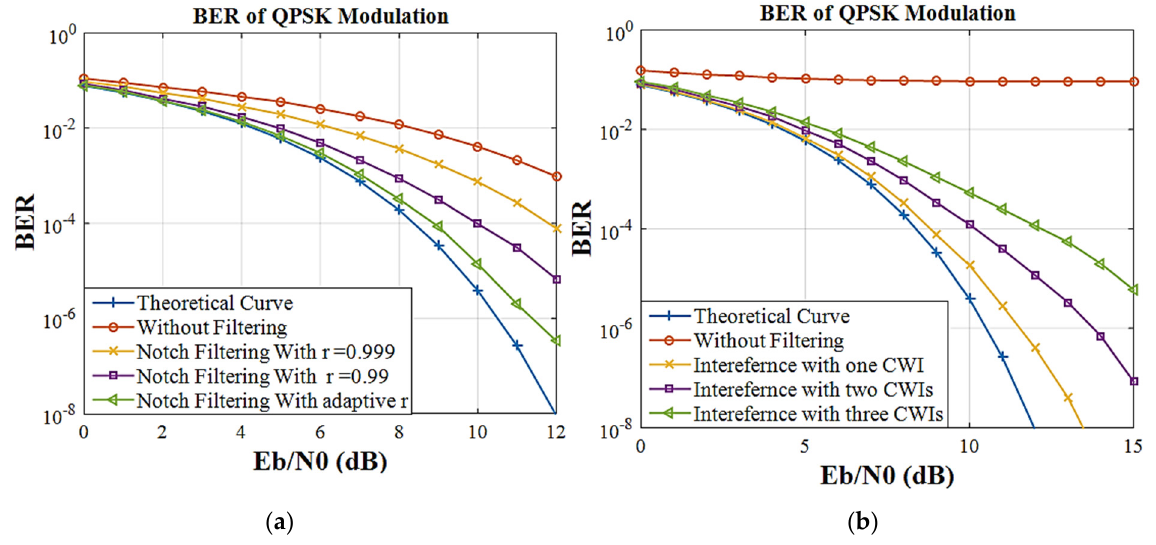
Figure 16. Bit Error Rate (BER) performance of Quadrature Phase Shift Keying (QPSK) in presence of interference ( a ) CWI with variable power, ( b ) Multiple Carrier Wave Interferences (MCWI) with variable power.